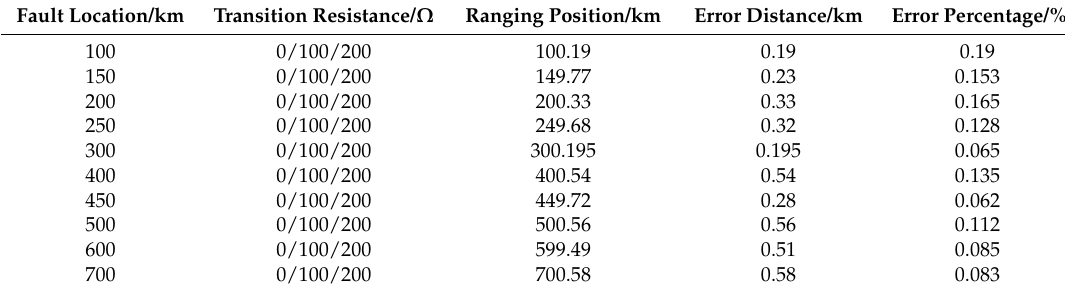
Table 1. Distance measurement results of a two-segment line with different fault points and transition resistances.